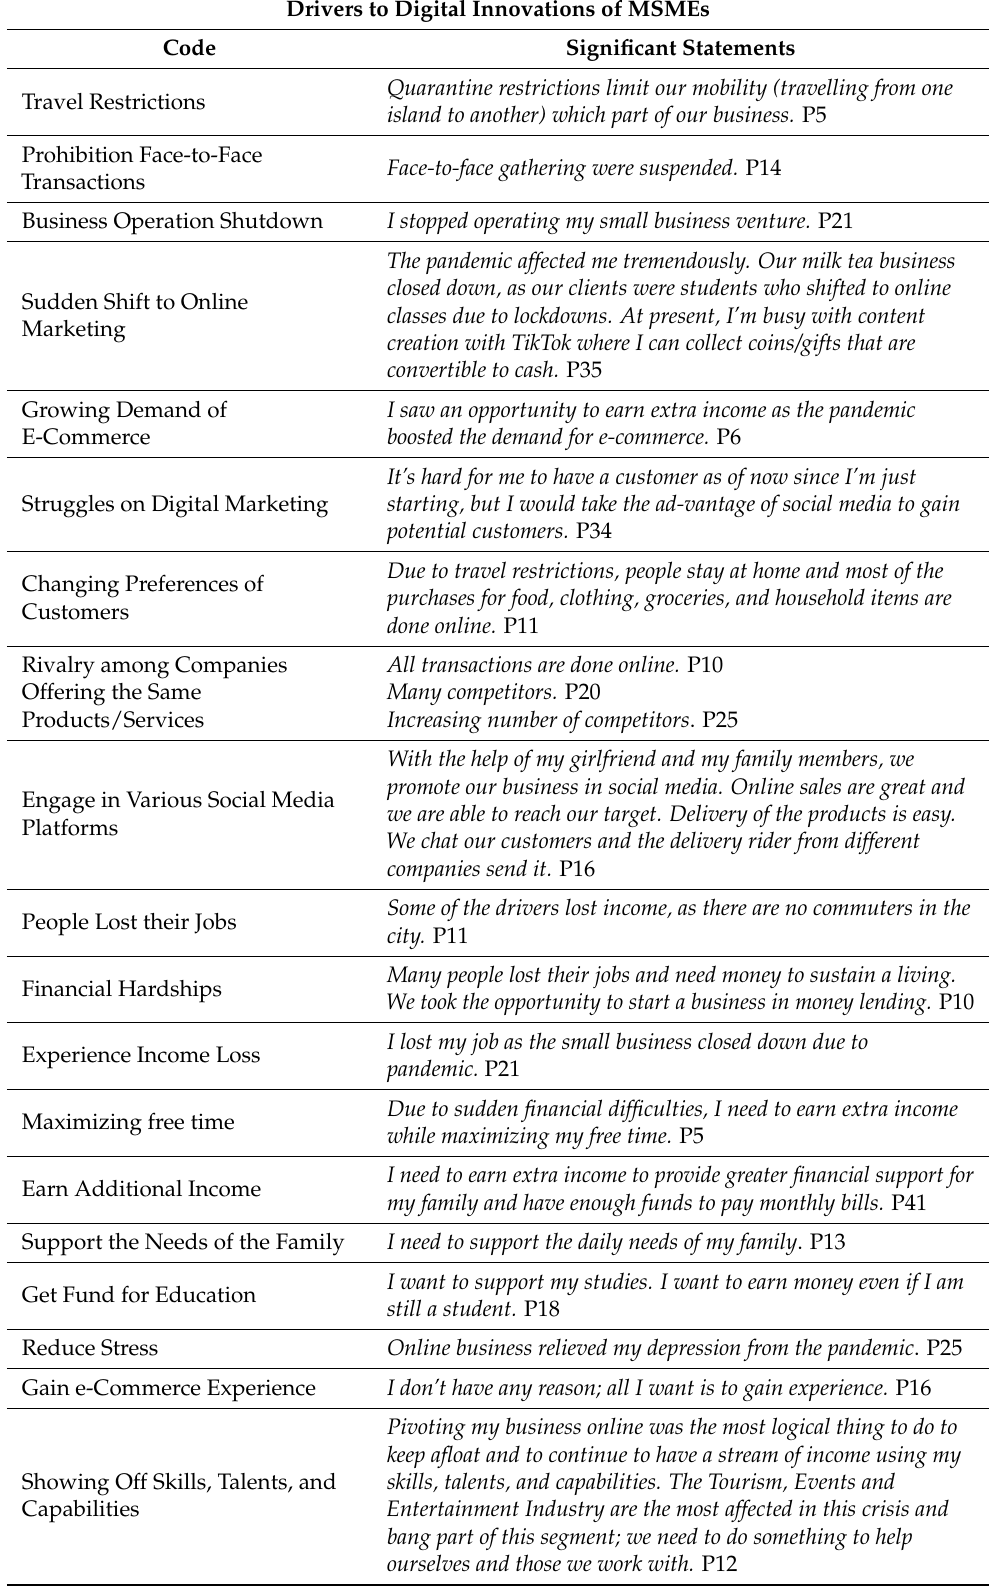
Table A2. Summary of Codes and Relevant